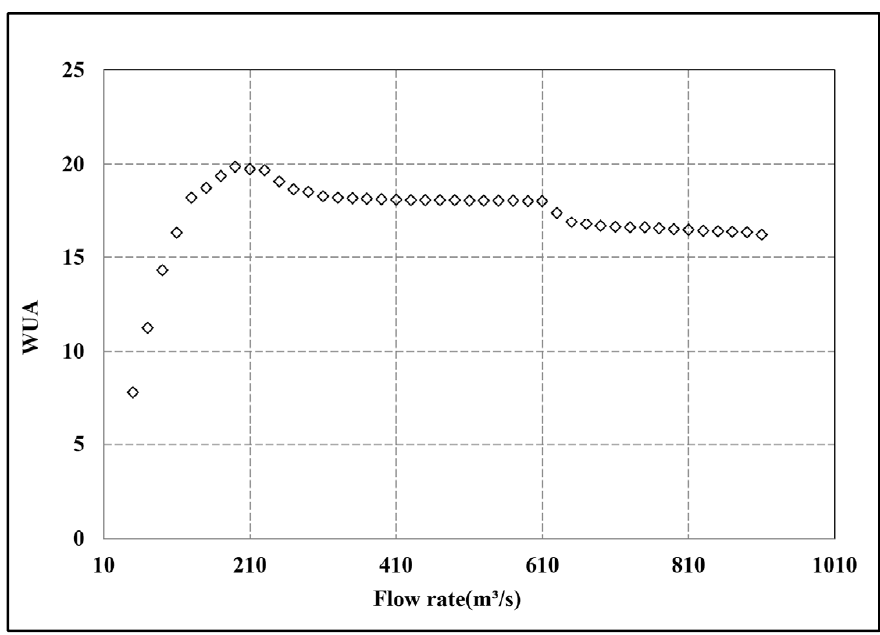
Figure 11. Averaged values of WUA according to flow rate variations .